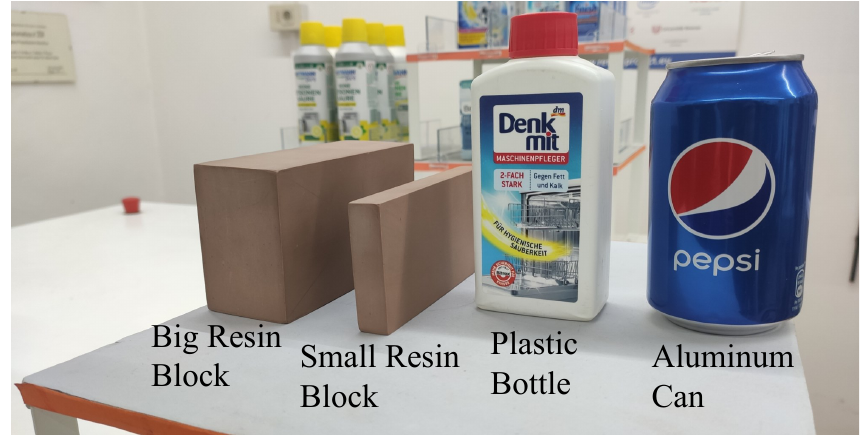
Figure 9. Experimental setup.